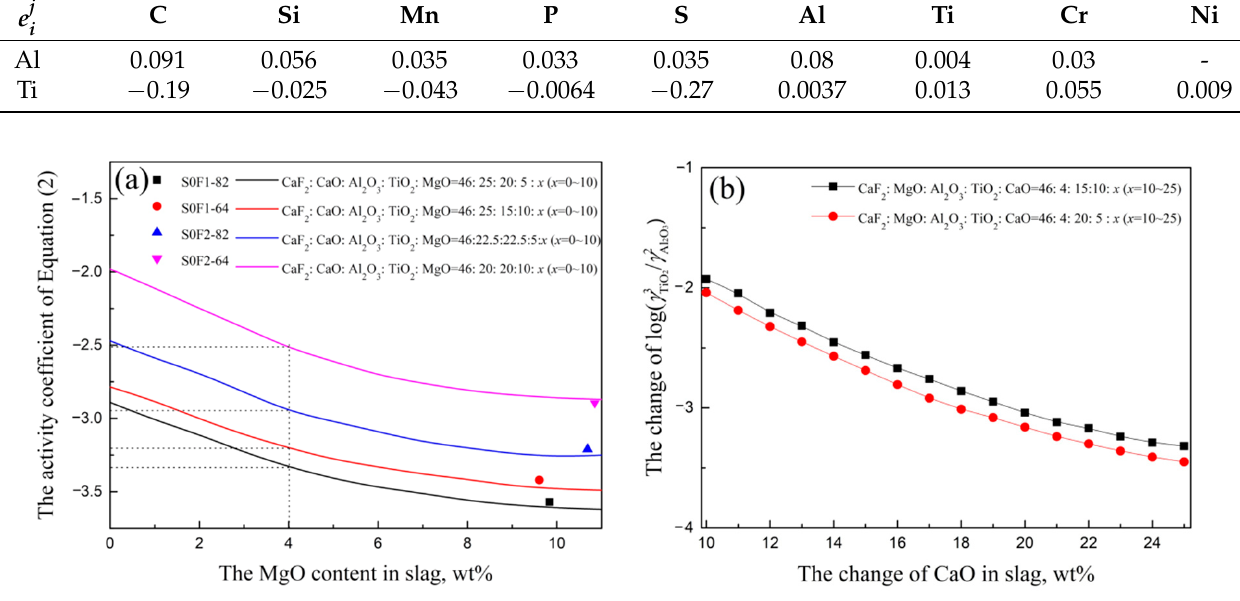
γγ / γ 2 ) with CaO 2 OAl3 TiO 2 Al 2 O 3 ) with TiO 322